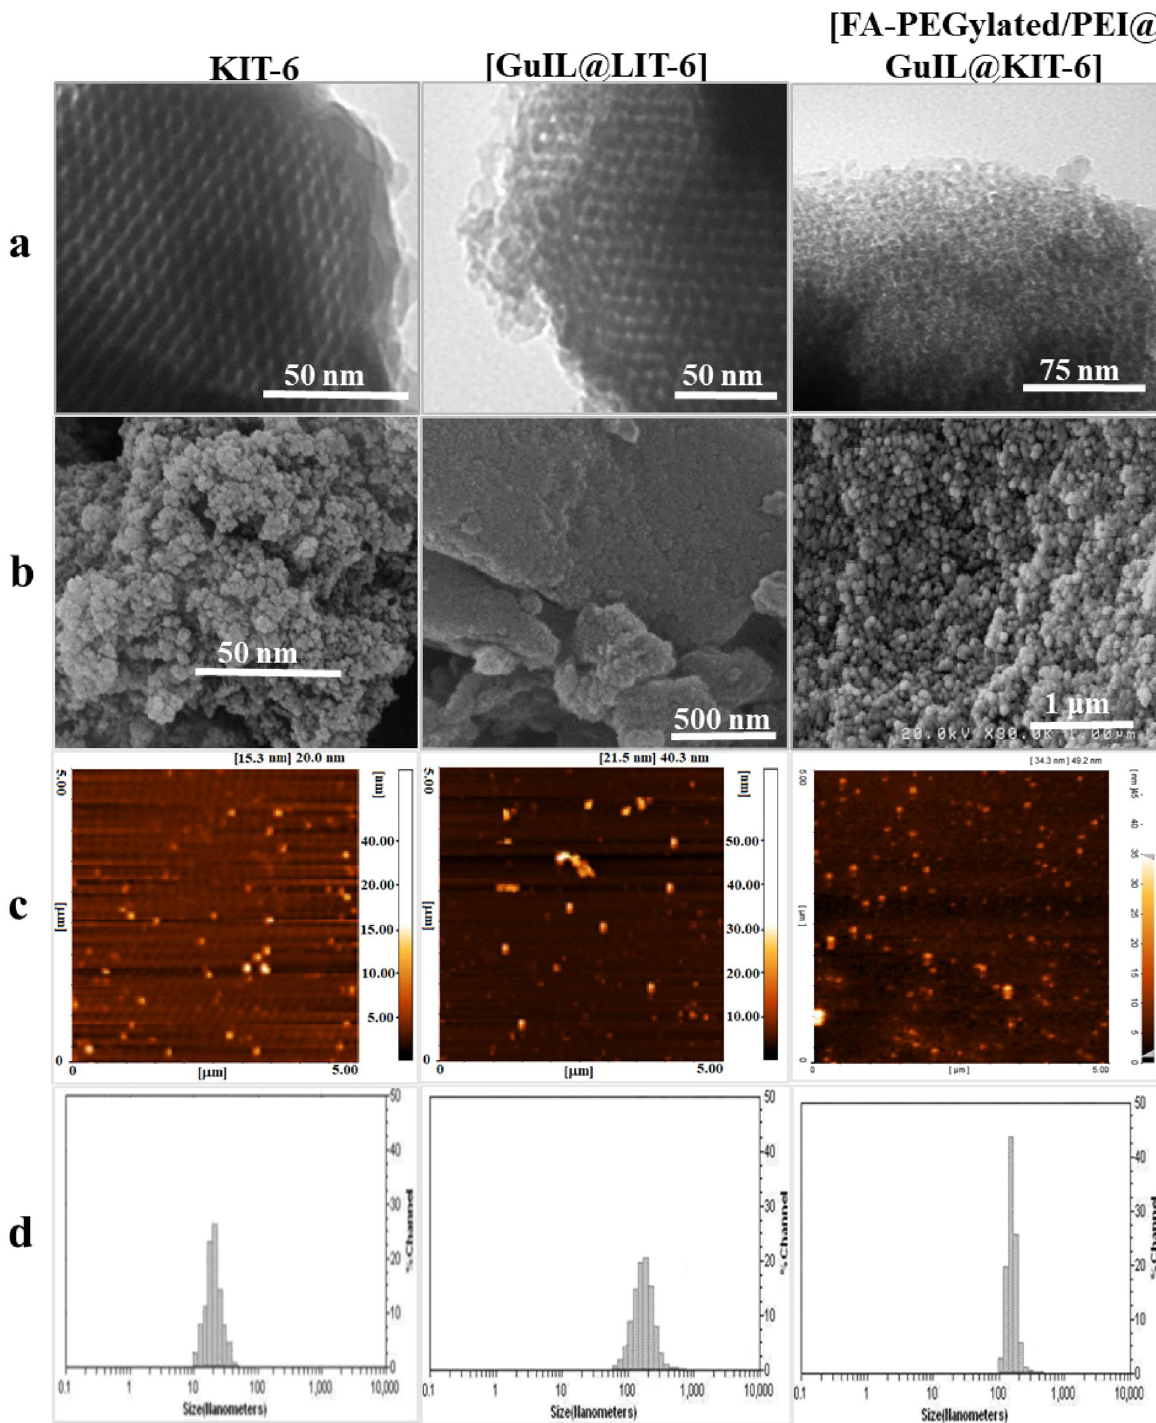
Figure 2. ( a ) TEM, ( b ) SEM, ( c ) AFM and ( d ) DLS images and ( e ) BET/BJH results of KIT-6, GuIL@KIT-6 and [FA-PEGylated/PEI@GuIL@KIT-6]